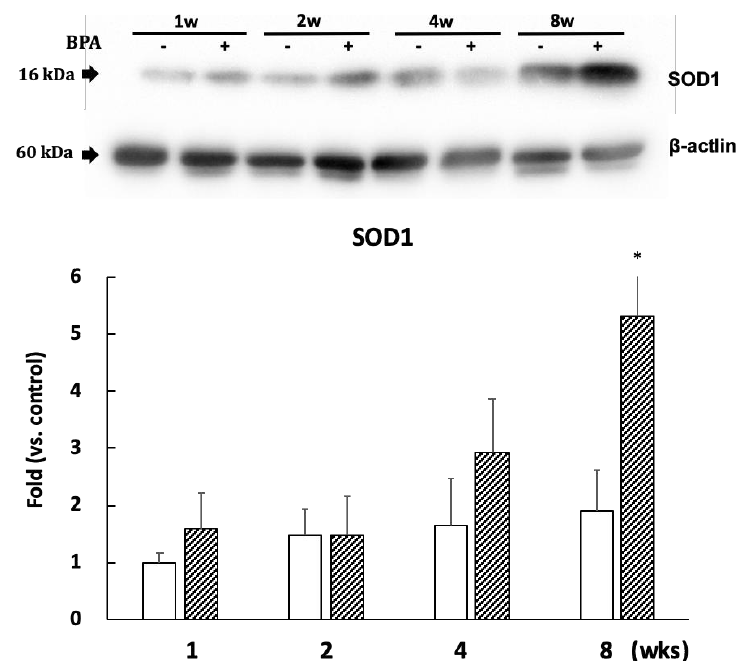
Figure 6. Effect of BPA on SOD1 levels. Open column, control and gray column, BPA. Values are mean ± SD ( n = 3 to 6). * p < 0.05 as compared with each control group.